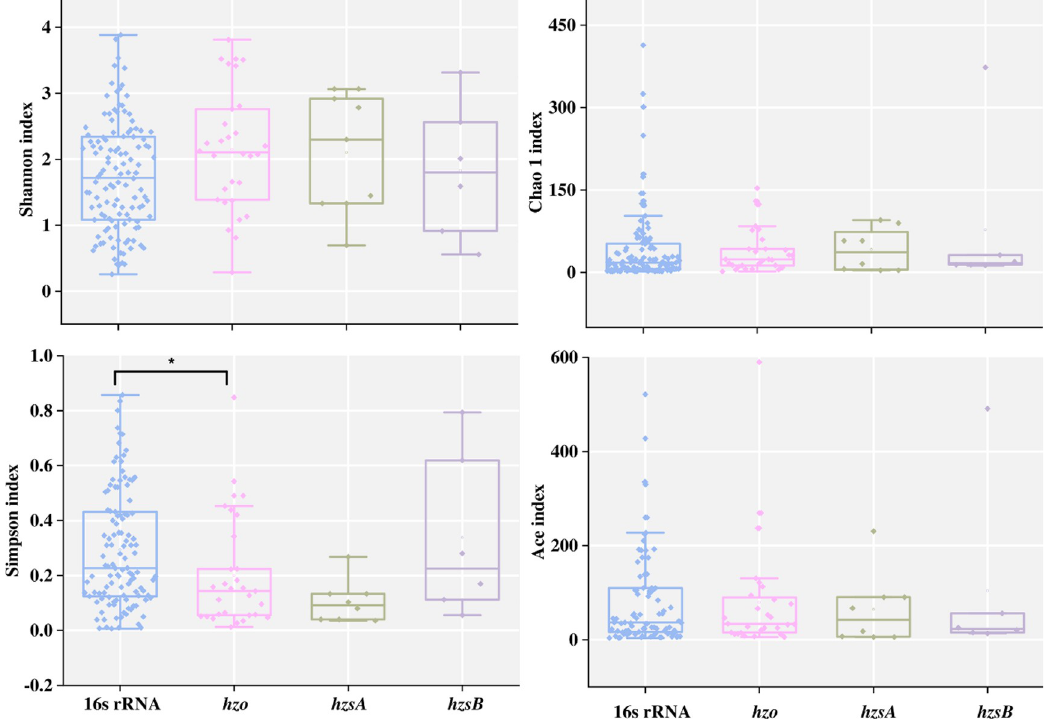
Fig 4. Alpha diversity revealed by the 4 marker genes, significant difference was marked with asterisk ( � ).